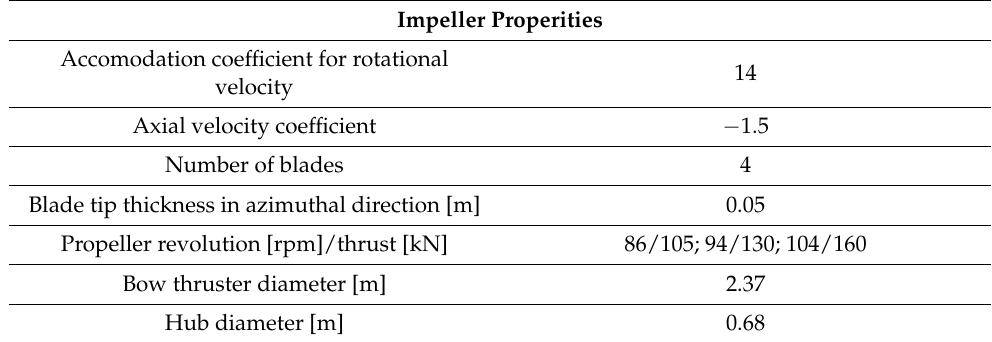
Table 3. Parameters of the virtual bow thruster–impeller properties.